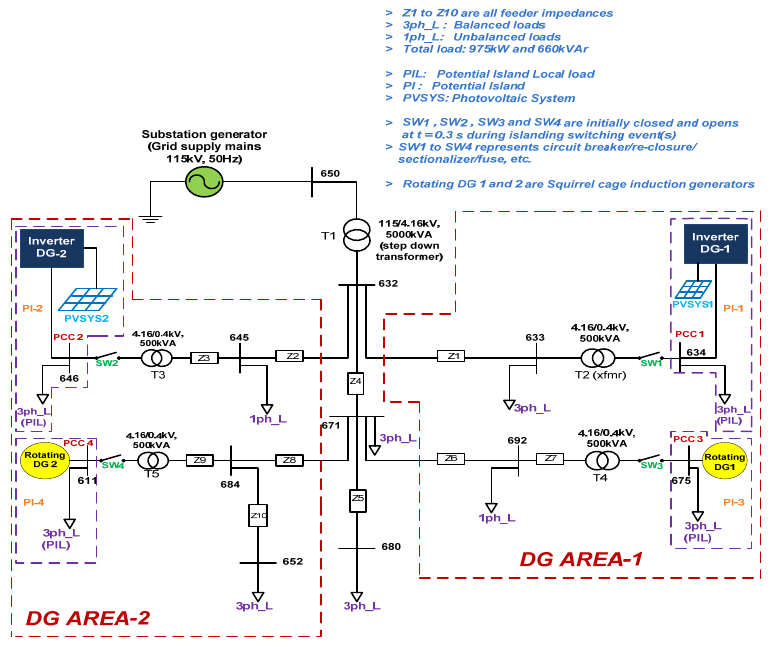
Figure 2. IEEE 13 bus distribution test feeder integrated with PV inverter and rotating DG sources.